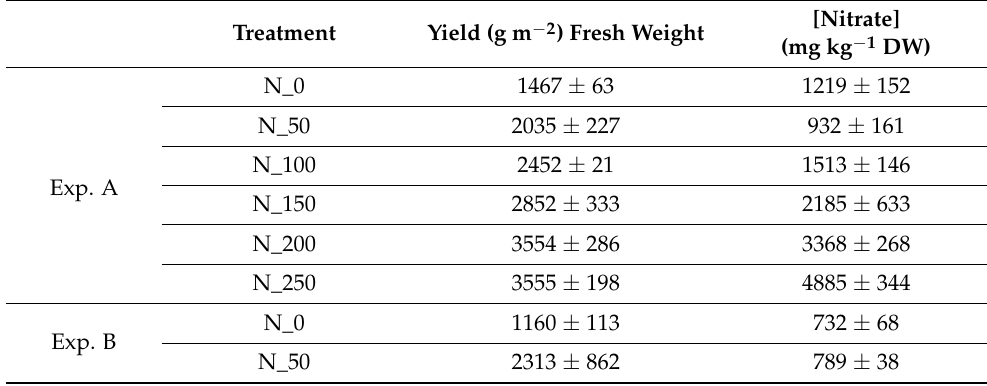
Table 2. Yield (g m − 2 ) and Nitrate content ([Nitrate]; mg kg − 1 dry weight, DW) as recorded for spinach subjected to different N availabilities (0, 50, 100, 150, 200, and 250 kg N ha − 1 : N_0, N_50, N_100, N_150, N_200, and N_250, respectively) in 3 different experiments (Exp. A, B, and C) during 2020–2022 (see Table 1). Data are expressed as treatment average ± standard